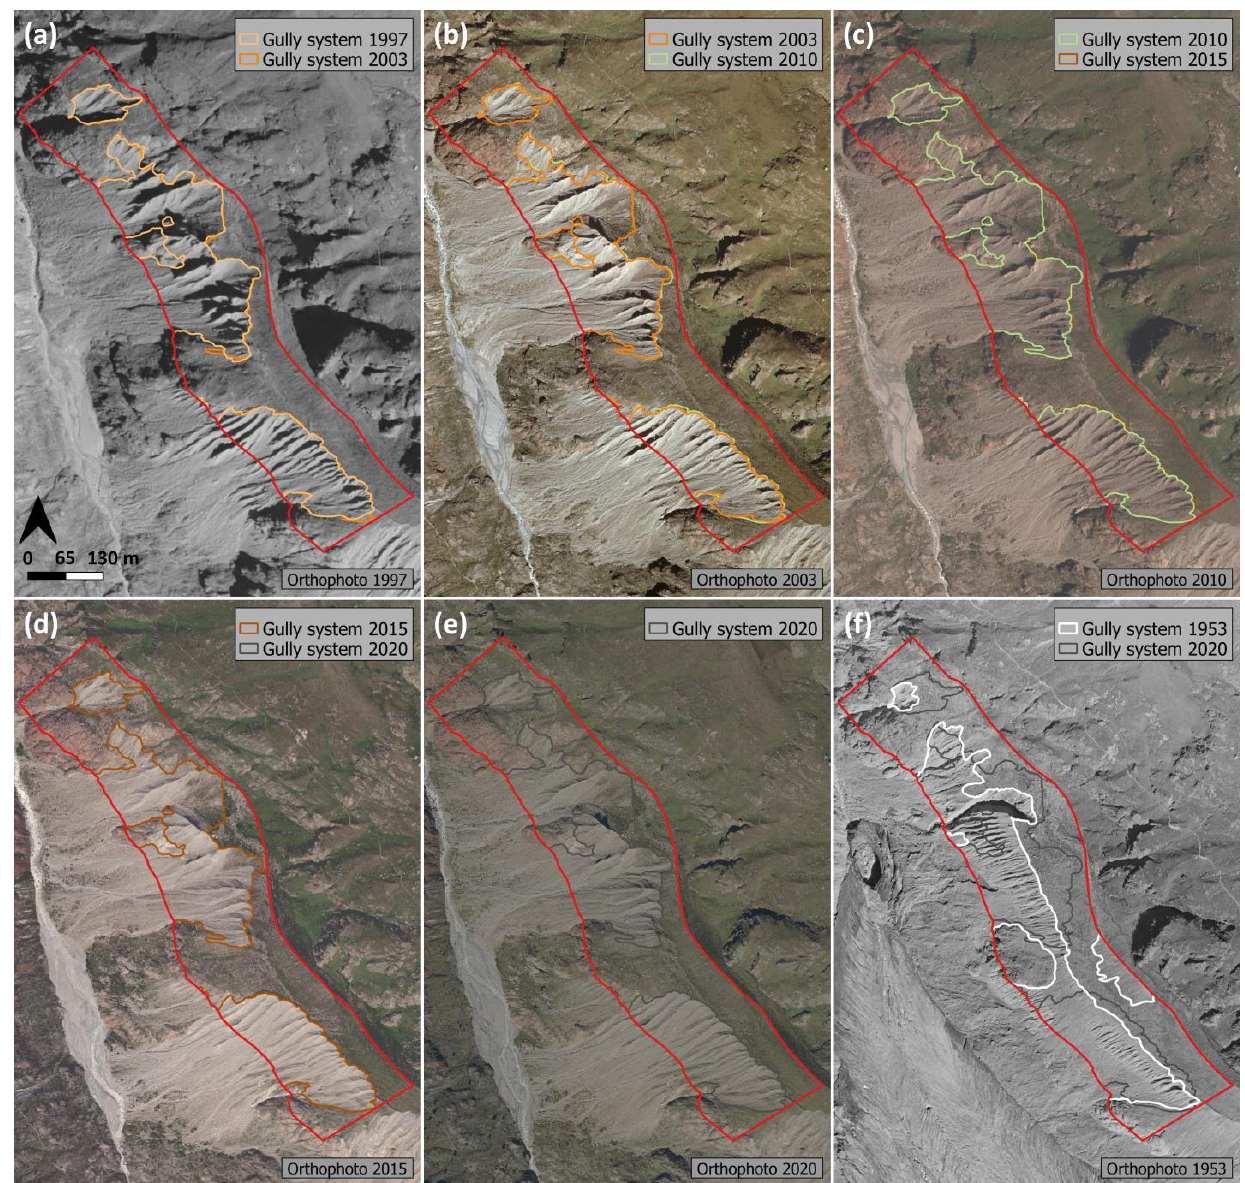
Figure A4. Continued mapping of the different surface types (morphodynamic mapping) using georeferenced orthophotos based on overlapping area-wide aerial photographs from 1997 to 2020 ( a – f ). The red line indicates the area of interest.